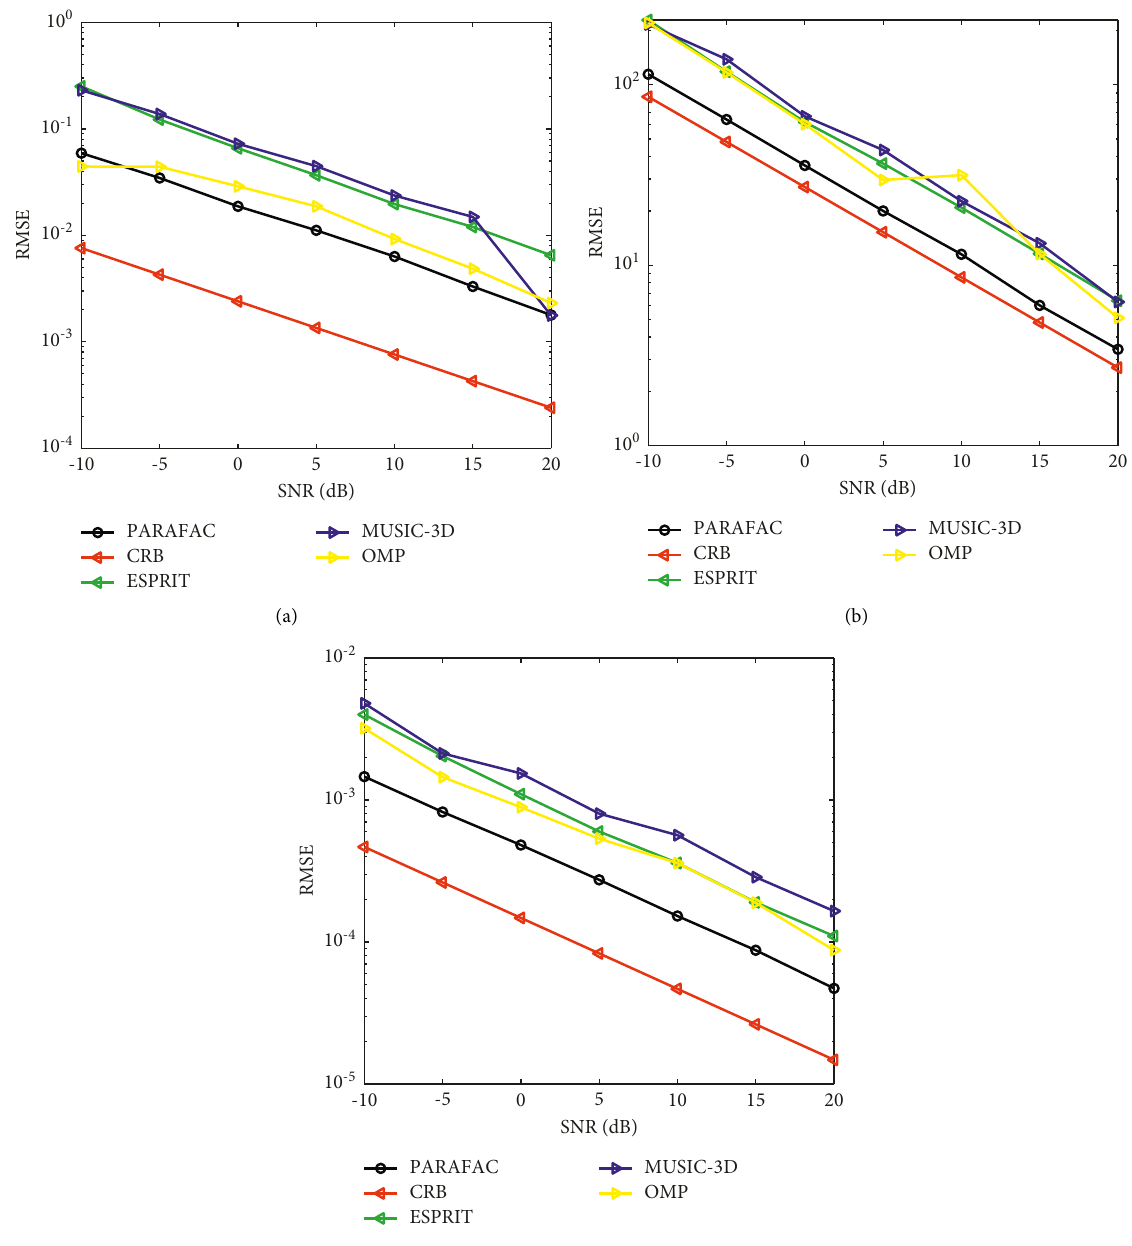
Figure 3: RMSEs and CRB versus SNR for parameter estimation (a) the angle, (b) the range, and (c) the